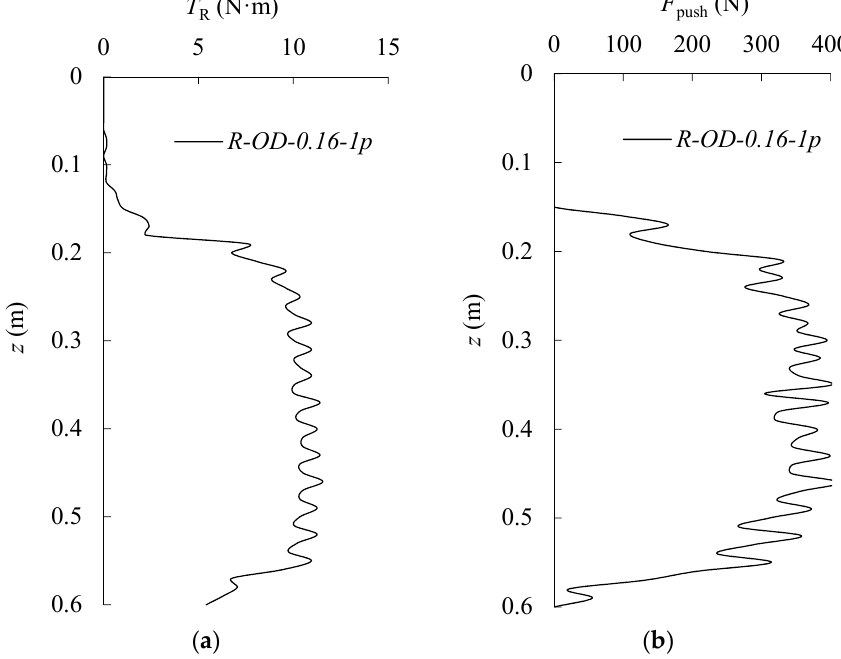
Figure 7. The test results about TN-2. ( a ) Recycling torque. ( b ) Vertical force on shaft.